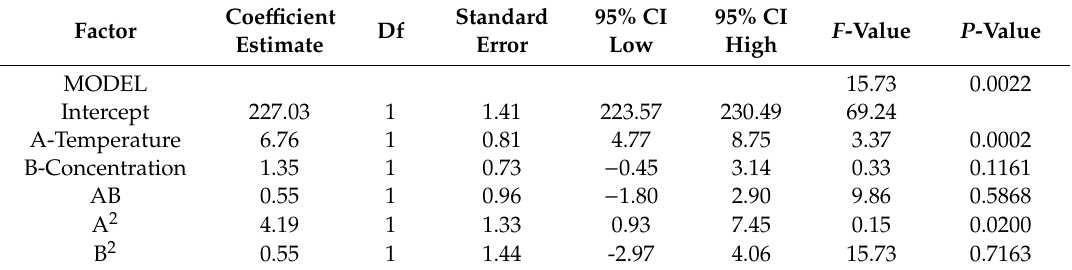
Table 5. Quadratic model regression coe ffi cients statistical analysis.